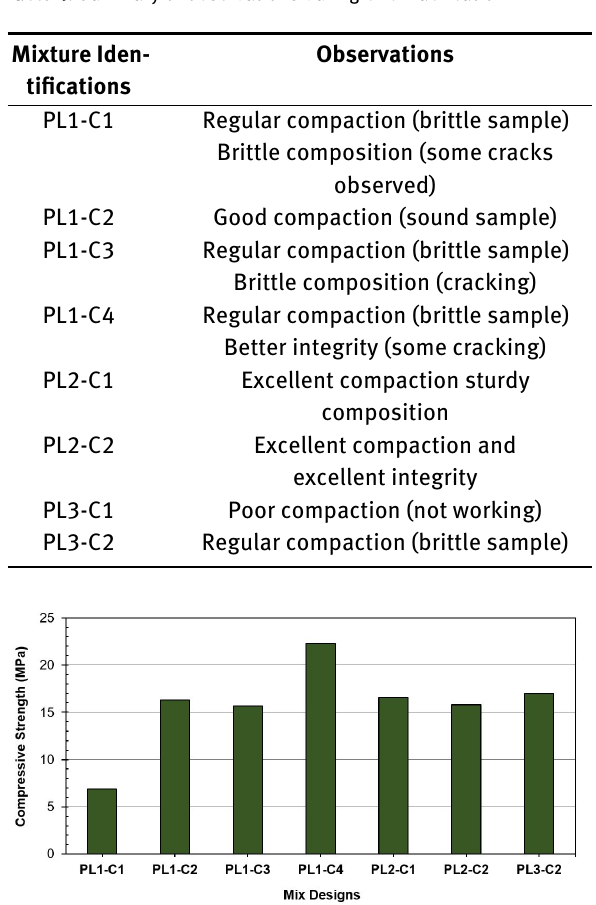
Table 4: Summary of observations during brick fabrication